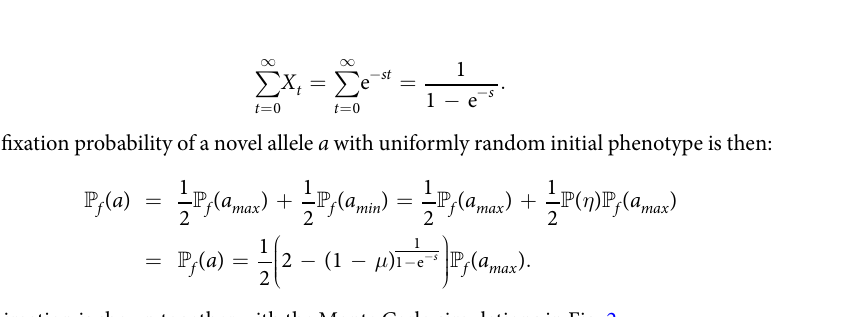
Figure 3. Fixation of a phenotypically variable allele in a periodic environment. ( A ) The dots show the fixation probability of a novel a allele in a population of size N = 1000 as a function of the phenotypic memory parameter p , determined by Monte Carlo simulation. In all cases we set f 1 ( Φ A )) = 0.6 and f 2 ( Φ A )) = 0.8. The fitness of an a allele in the first environment, f 1 ( Φ a ) is sampled uniformly in the interval [0.7, 0.9], wheres f 2 ( Φ a ) is uniform on the interval [0.5, 0.7]; and so that each allele as the same expected fitness in its preferred environment. The initial environment is chosen at random. The colors represent different rates of environmental change, as presented in the legend. ( B ) The environmental duration is plotted on the x -axis against 1 − p * , where p * is the value of phenotypic memory that maximizes the probability of fixation of a novel a allele. Different colors represent different population sizes, N , as indicated. The phenotypic variance of the a allele, Var ( Φ a ), is set to 0.0033. The curves show cubic spline fits to the simulated